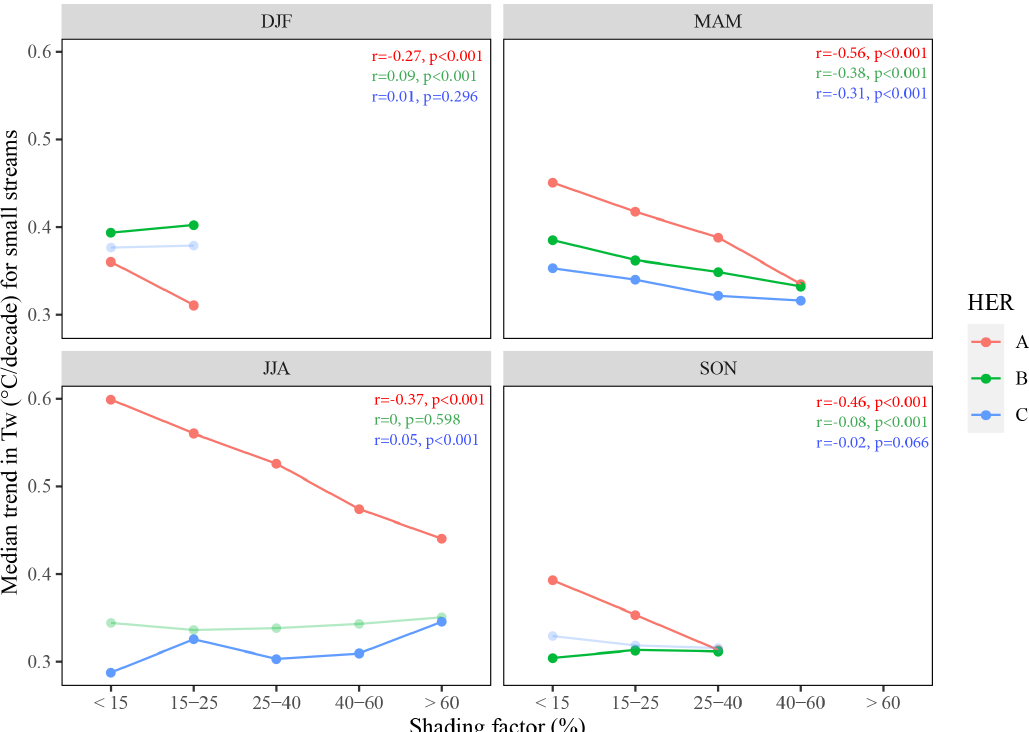
Figure 9. Relationships between shading factor and median trends in T w over the 1963–2019 period for small streams, by HER and by season. Note that some shading factor classes are not observed in autumn and winter. Correlations and associated p values are shown in the top right corner of each graph, and significant relationships at the 95% confidence level are identified by full solid